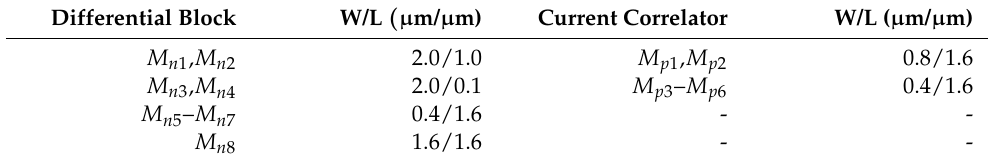
Table 3. MOS transistors’ dimensions (Figure 2).